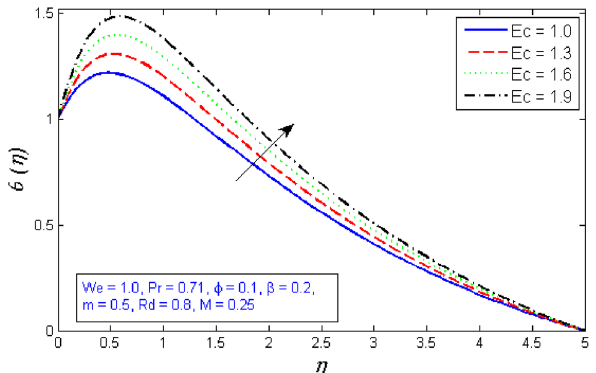
Figure 22. Represents variation of temperature distribution for numerous number of Eckert number Ec .